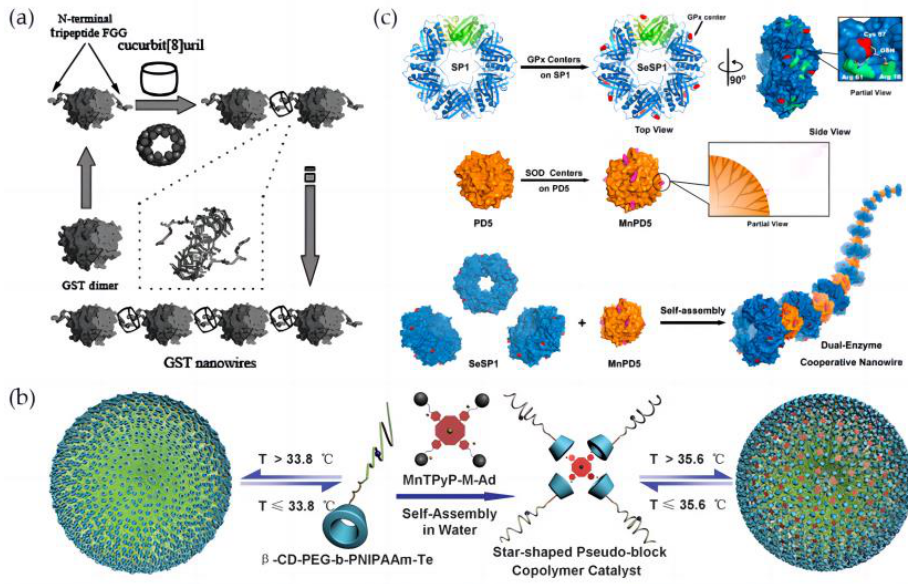
Figure 7. Different assembly methods of artificial selenoenzymes. ( a ) Graphic representation of selenium-containing protein nanowires formed by host–guest interaction based on CB [8] and FGG. Reproduced with permission from C. Hou et al. [92]. ( b ) Graphical representation of a bifunctional selenoenyzme model with temperature response. Reproduced with permission from S. Yu et al. [93]. ( c ) Diagram of self-assembly of circular proteins induced by “soft nanoparticles” with multi -enzyme synergistic antioxidant capacity..Reproduced with permission from H. Sun et al. [96].